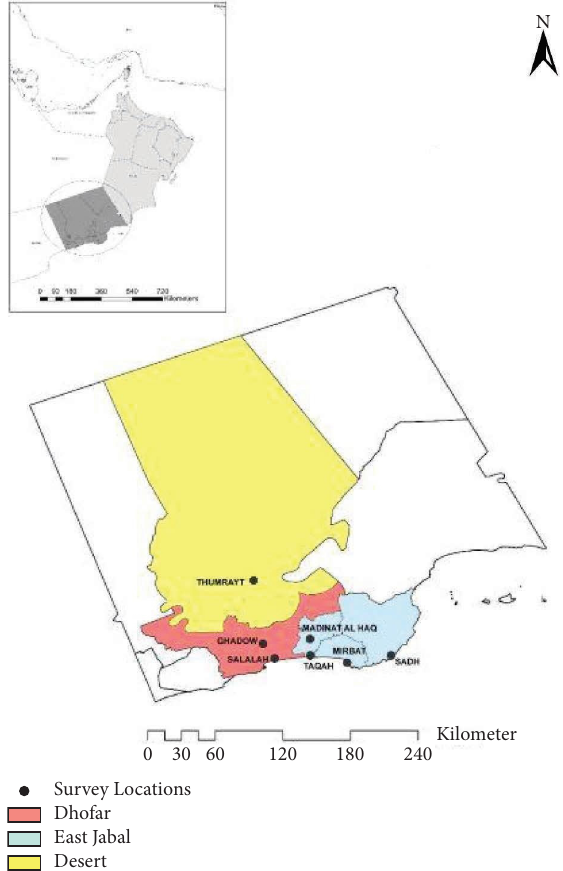
Figure 1: A map of Oman showing the three regions where the study was carried